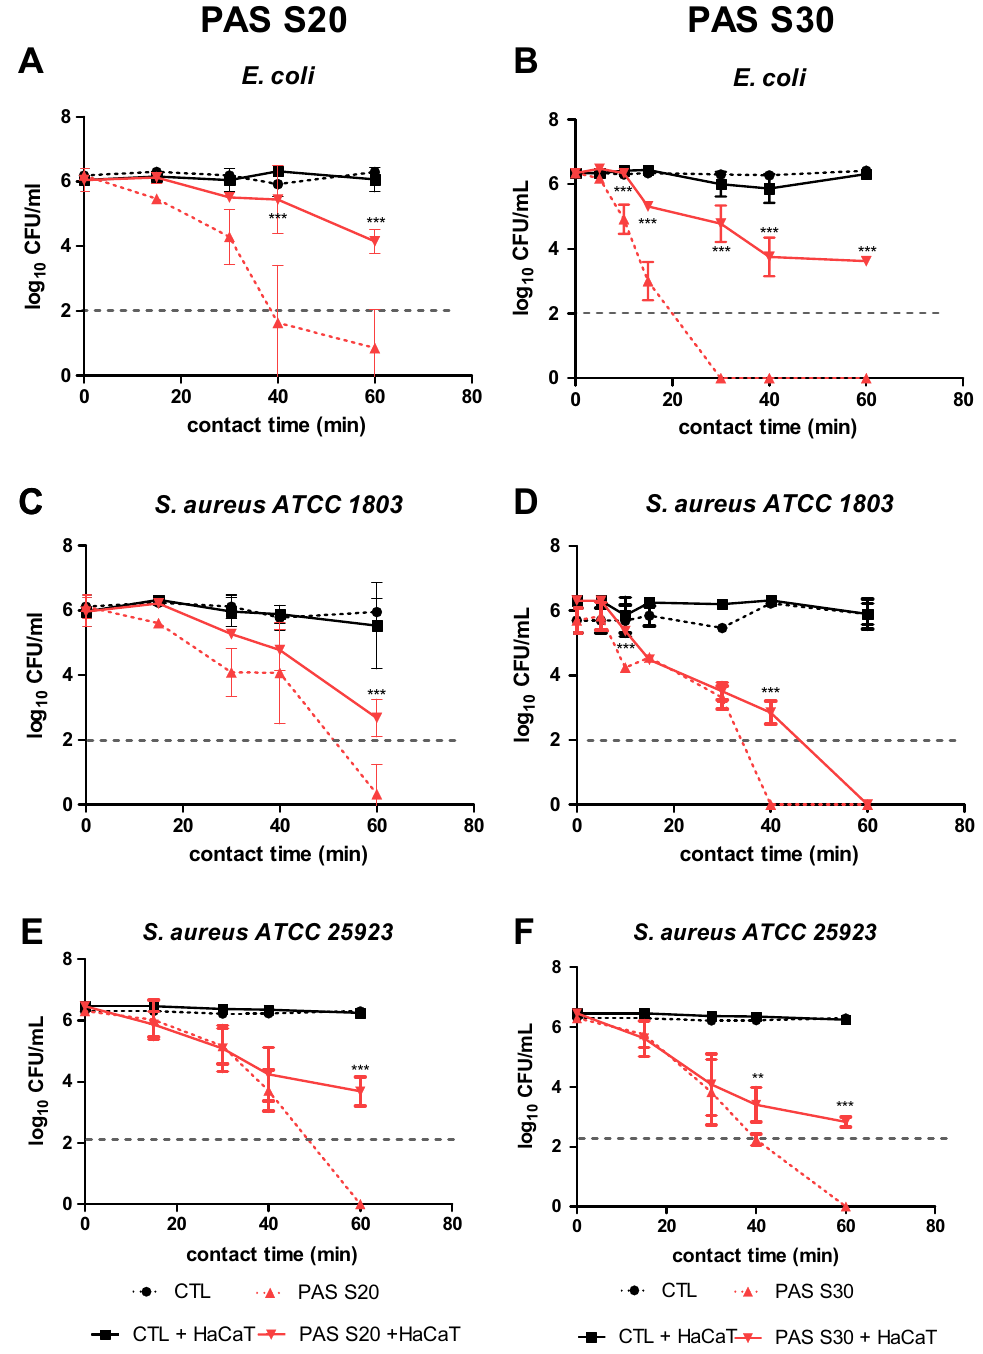
Figure 3. Bacterial inactivation in a co-culture model of HaCaT cells and E. coli or S. aureus under incubation with PAS 20 or PAS 30 as a function of contact time. ( A ) E. coli —PAS 20, ( B ) E. coli —PAS 30, ( C ) S. aureus ATCC 1803—PAS 20, ( D ) S. aureus ATCC 1803—PAS 30, ( E ) S. aureus ATCC 25923—PAS 20, ( F ) S. aureus ATCC 25923—PAS 30. The results are the mean ± S.D. of three determinations, limit of detection 2 log CFU/mL. Statistical significance is shown for comparison of bacteria + HaCaT cells (co-culture) incubated with PAS to only bacteria (no co-culture) incubated with PAS, with significance levels indicated as *** p < 0.001, ** p < 0.01, * p <